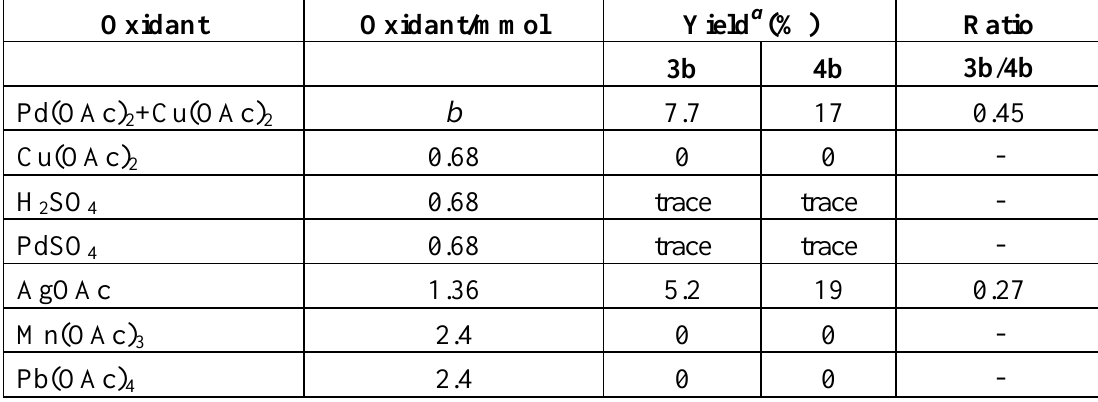
Table 4. Effects of oxidants in the reactions of dimethyl disulfide ( 1 ) (2.0 mmol) with hex-1-ene ( 2b ) (4.8 mmol) in the presence of oxidant in AcOH (10 cm 3 ) containing Ac O (1.0 cm 3 ) at 25 ° C for 24 h. 2 Oxidant Oxidant/mmol Yield a (%) Ratio 3b 4b 3b / 4b Pd(OAc) +Cu(OAc) b 7.7 17 0.45 2 2 Cu(OAc) 0.68 0 - 2 H SO 0.68 2 4 PdSO 0.68 trace - 4 AgOAc 1.36 2.4 2.4 - a The yields are calculated to be 100% when two moles of product are formed from one mole or Cu(OAc) and from two moles Pd(OAc) 2 2